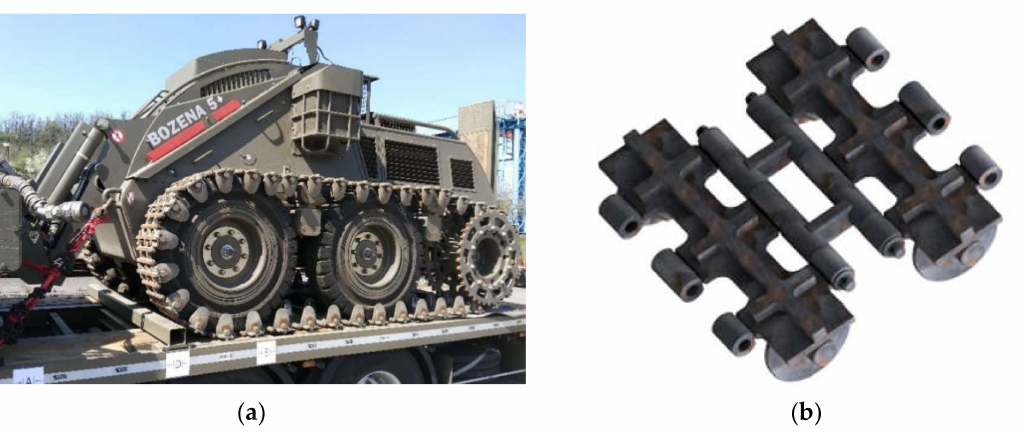
Figure 1. ( a ) A demining machine Božena 5; ( b ) a segment of the